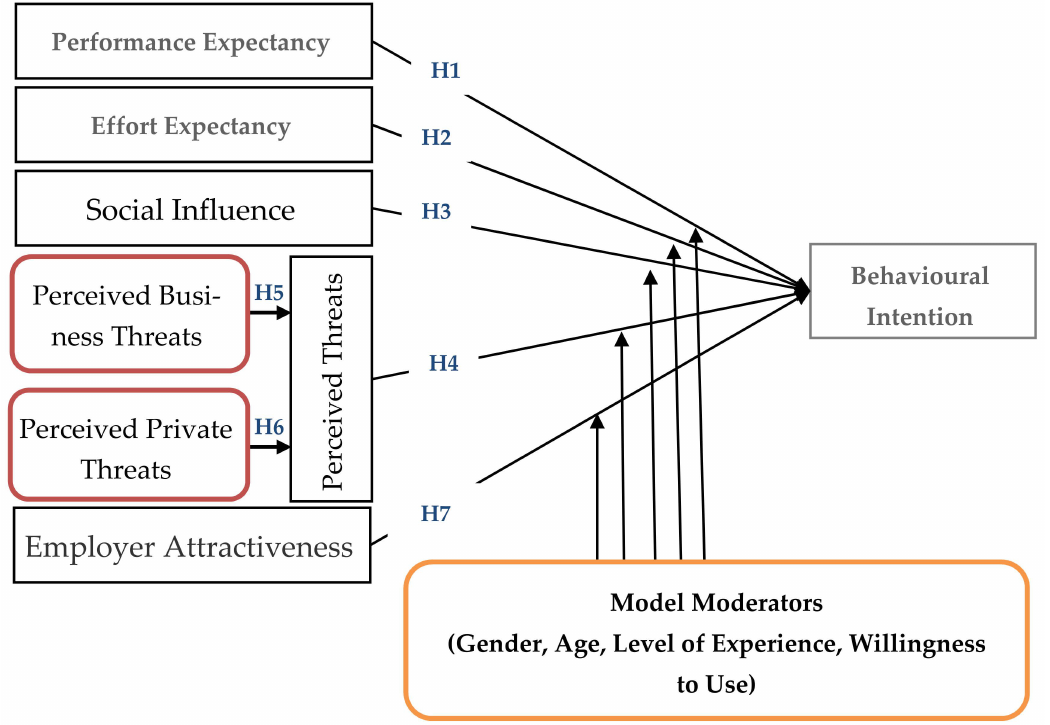
Figure 1. The modified UTAUT model for BYOD